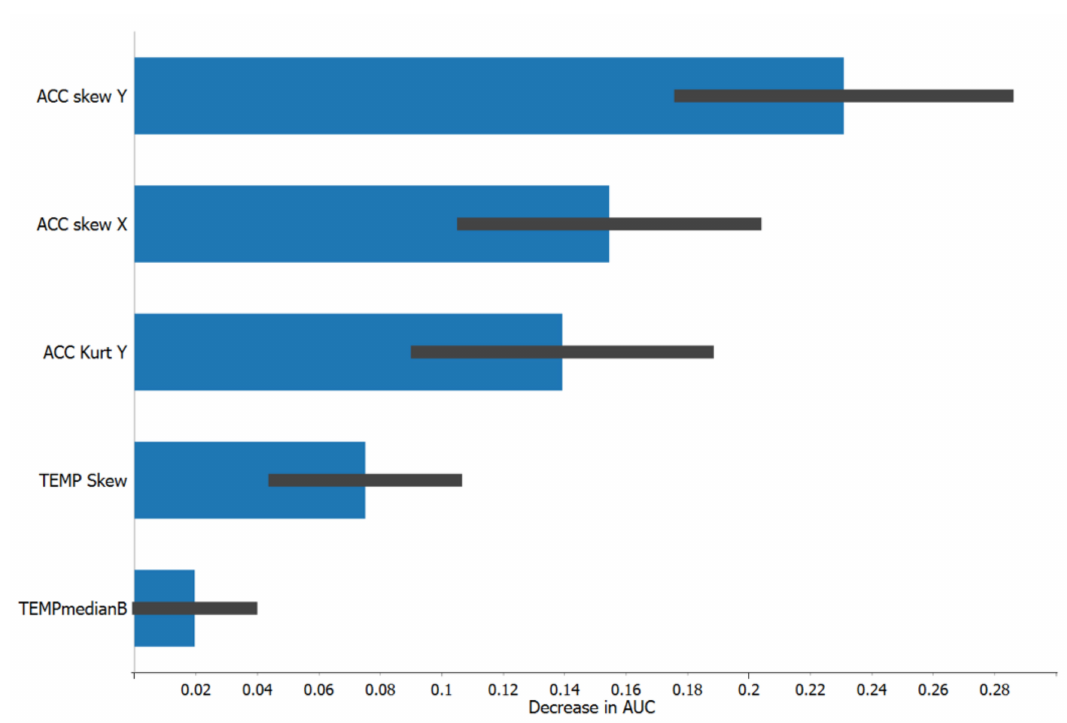
Figure 3. Relative importance of the five features in terms of the average decrease in the AUC value for the Study 1 logistic regression model associated with randomly shuffling a feature in the data. 1000 random shuffles were used for each feature. Mean (blue bar) and standard deviation (black line) for reduction in AUC across the 1000 random shuffles is